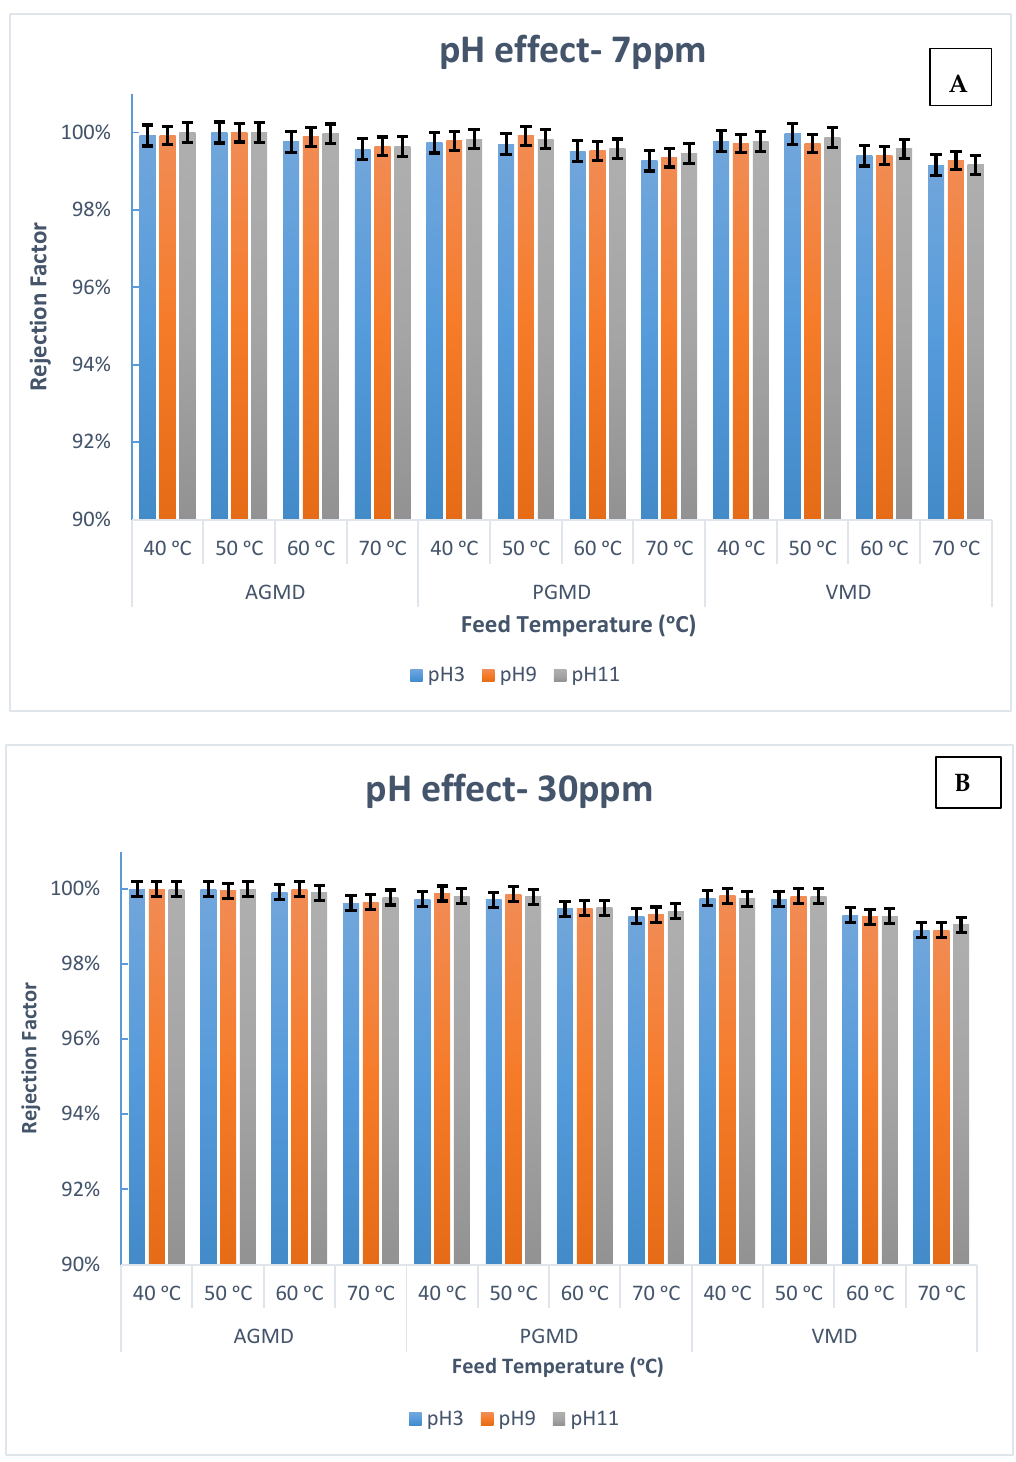
Figure 7. Boron rejection for AGMD, PGMD, and VMD at different pH values and feed temperatures for initial boron concentrations: ( A ) 7 ppm; ( B ) 30 ppm.